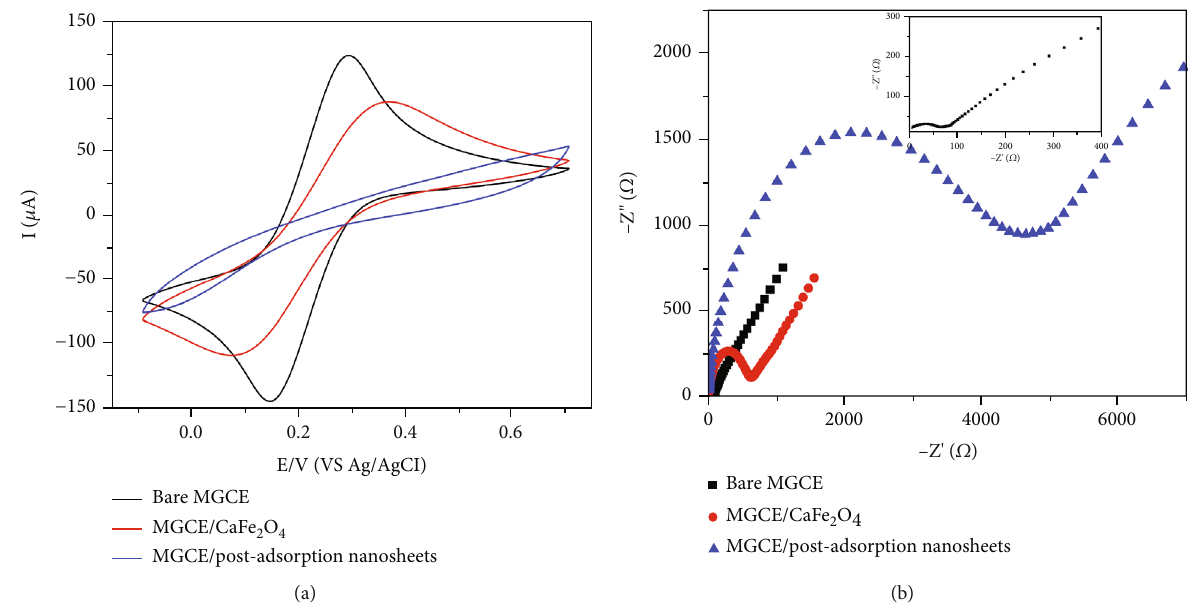
Figure 8: CV (a) and EIS (b) results of bare MGCE, MGCE/CaFe